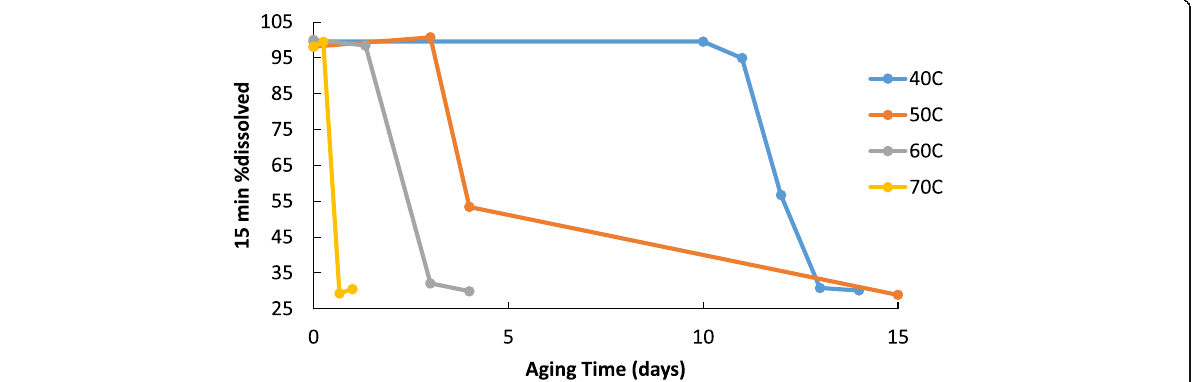
Fig. 1 Dissolution behavior of an immediate release tablets as a function of time, for several temperatures (at 80%RH). (permitted to reprint)